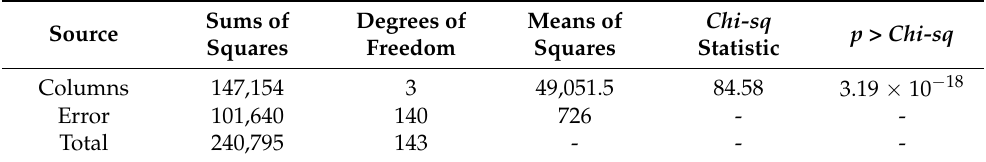
Table 8. Results of Kruskal–Wallis test for oil Midel 1204 with different concentrations of surfactant Triton X.